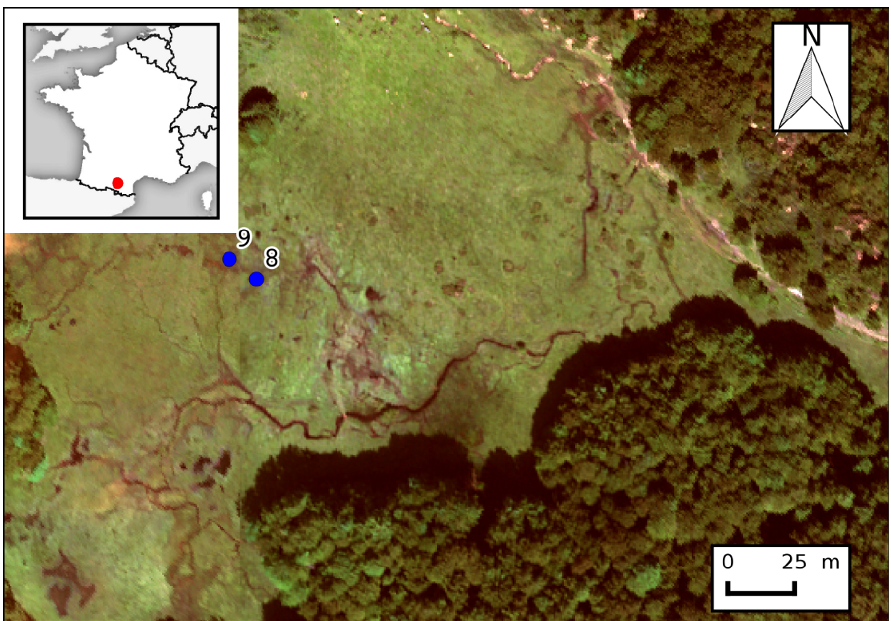
Figure A5. Location of the in situ spectroradiometer measurements for the plots of Eleocharis quinqueflora (ELQU).